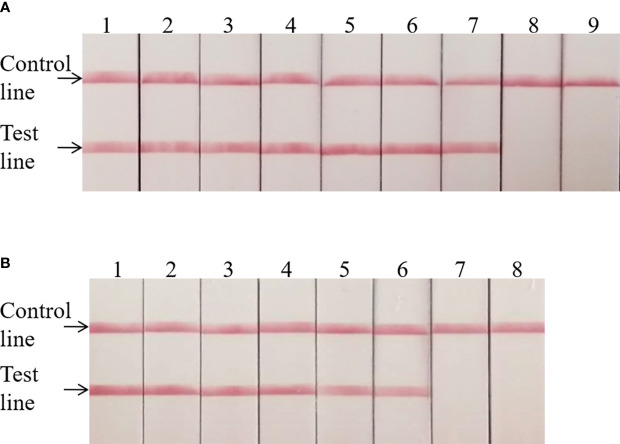
Analytical sensitivity of the LFS RPA assay. The LOD of the LFS RPA method was 1.1 × 102 fg for genomic DNA and 1.4 × 102 CFU/ml for bacteria in pure culture. For (A): Sample 1, 1.1 × 108 fg; Sample 2, 1.1 × 107fg; Sample 3, 1.1 × 106 fg; Sample 4, 1.1 × 105 fg; Sample 5, 1.1 × 104 fg; Sample 6, 1.1 × 103 fg; Sample 7, 1.1 × 102 fg; Sample 8, 1.1 × 101 fg; Sample 9, 1.1 × 100 fg. For (B): Sample 1, 1.4 × 107 CFU; Sample 2, 1.4 × 106 CFU; Sample 3, 1.4 × 105 CFU; Sample 4, 1.4 × 104 CFU; Sample 5, 1.4 × 103 CFU; Sample 6, 1.4 × 102 CFU; Sample 7, 1.4 × 101 CFU; Sample 8, 1.4 × 100 CFU.